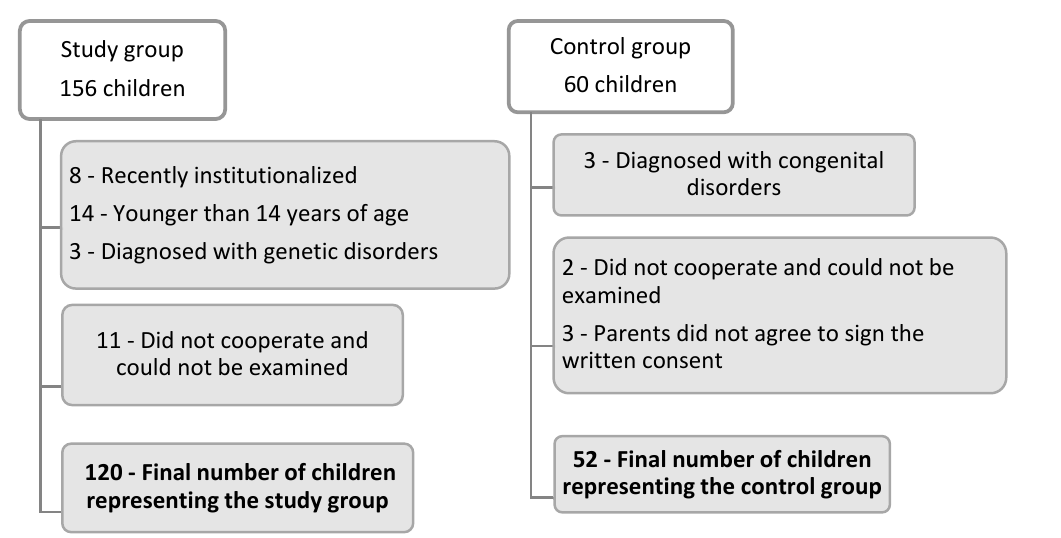
Figure 1. Diagram illustrating the selection of the young patients included in the study.